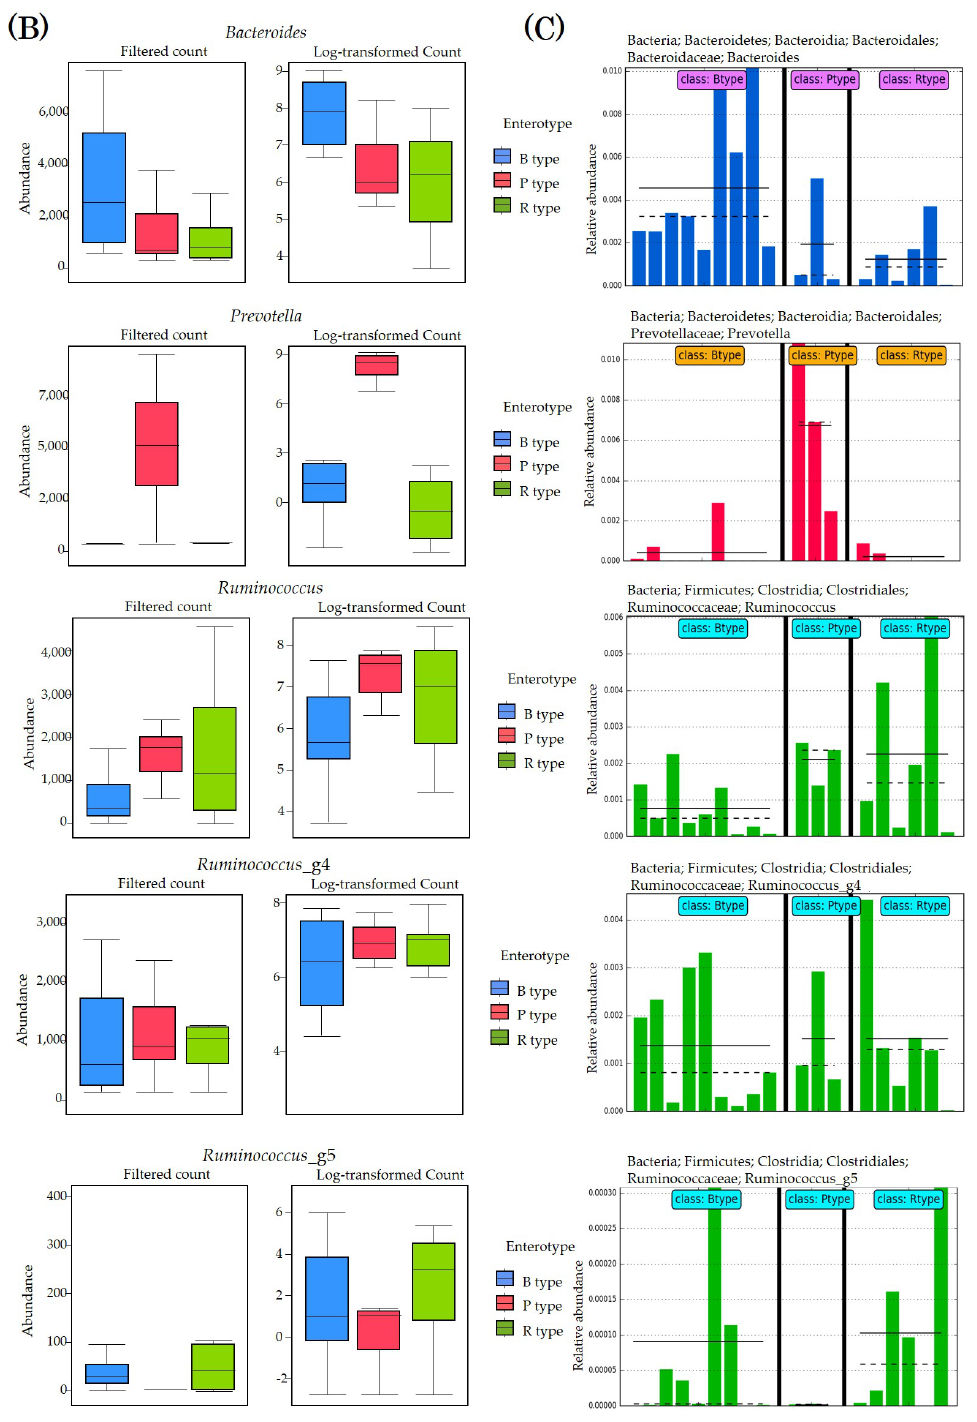
Figure 4. Enterotyping of all subjects. ( A ) PCoA for Genus level based on Bray–Curtis index through PERMANOVA analysis. Type B is marked with red plots ( n = 9), P type with blue plots ( n = 3), and R type with green plots ( n = 6). ( B ) Classical Univariate Statistical Comparisons. Taxonomy level was Genus level, Experimental factor was Enterotype, Statistical method was Kruskal–Wallis, and adjusted p -value cutoff was performed at 0.05. ( C ) Plot One Feature showing the distribution of a single variable. Plot One Feature can draw histograms and histograms of specific species of biomarkers from different sample groups. The different groups in the figure are separated by a solid black line. The solid line in each group of histograms represents the average value of the sample expression level of the group, and the dashed line represents the median value of the sample expression level of the group. Bacteroides of B type are blue bars, Prevetella of P type are red bars, and Ruminococcus of R type (and Ruminococcus_g4 , Ruminococcus_g5 ) are green